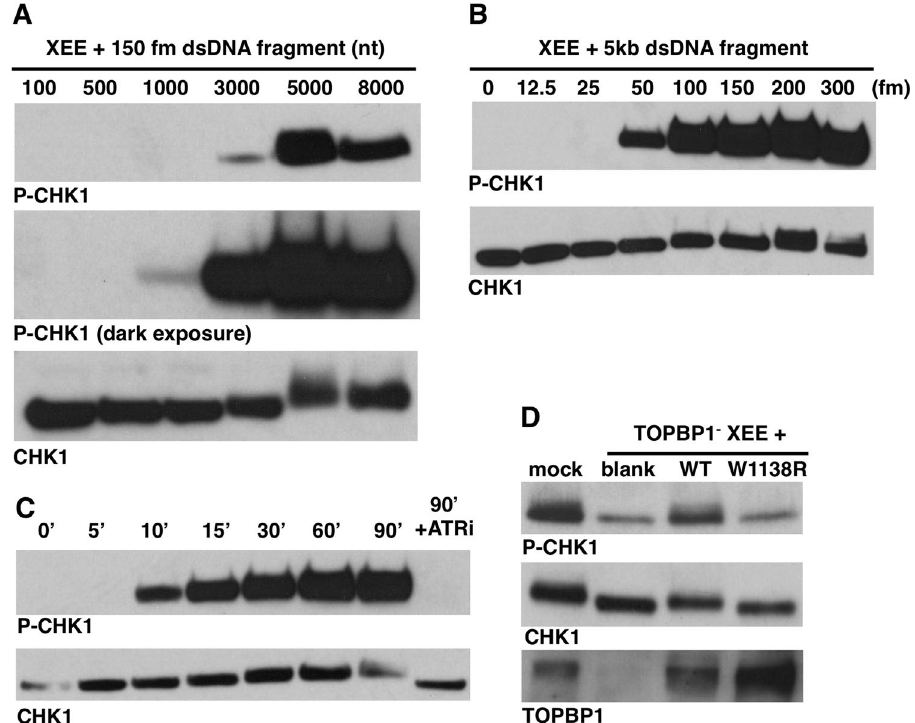
Figure 3. Basic properties of the DMAX system. ( A ) DMAX assay where dsDNA fragments of the indicated size (in nucleotides) were added to HSS at the indicated concentration. After 60-min incubation the samples were probed for P-CHK1 and CHK1. ( B ) DMAX assay where dsDNA fragments of the indicated sizeconcentration were added to HSS at the indicated concentration. After 60-min incubation the samples were probed for P-CHK1 and CHK1. ( C ) DMAX assay where HSS and 150 fmol of a 5kB dsDNA fragment were incubated together and samples were taken at the indicated time points. ATRi was included in the final sample, at 100 μM. Samples analyzed as in ( A ). ( D ) HSS was immunodepleted using either non-specific IgG (sample “mock”) or HU142, and antibody that recognizes TOPBP1 (samples “TOPBP1 - HSS + ”). The depleted extracts were then supplemented with either an unprogrammed IVTT reaction (sample “blank”) or IVTT reactions programmed for production of wild type TOPBP1 (“WT”) or the indicated TOPBP1 point mutant (“W1138R”). The reconstituted extracts were then supplemented with 150 fm of the 5 kB dsDNA fragment and, after incubation, the samples were probed by Western blotting for the indicated proteins. HU142, raised against Xenopus TOPBP1 44 , was used to probe for